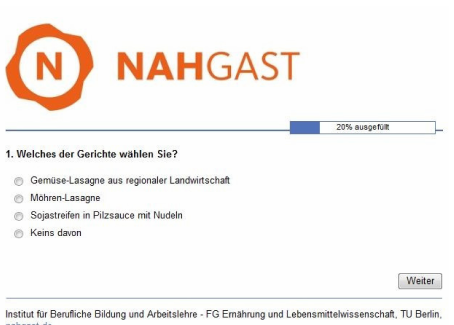
Figure A1. Exemplary choice set of Study II. Translation: Which of the dishes do you choose? Vegetable lasagne from regional agriculture vs. carrot lasagne vs. soy strips with noodles in mushroom sauce vs. none of